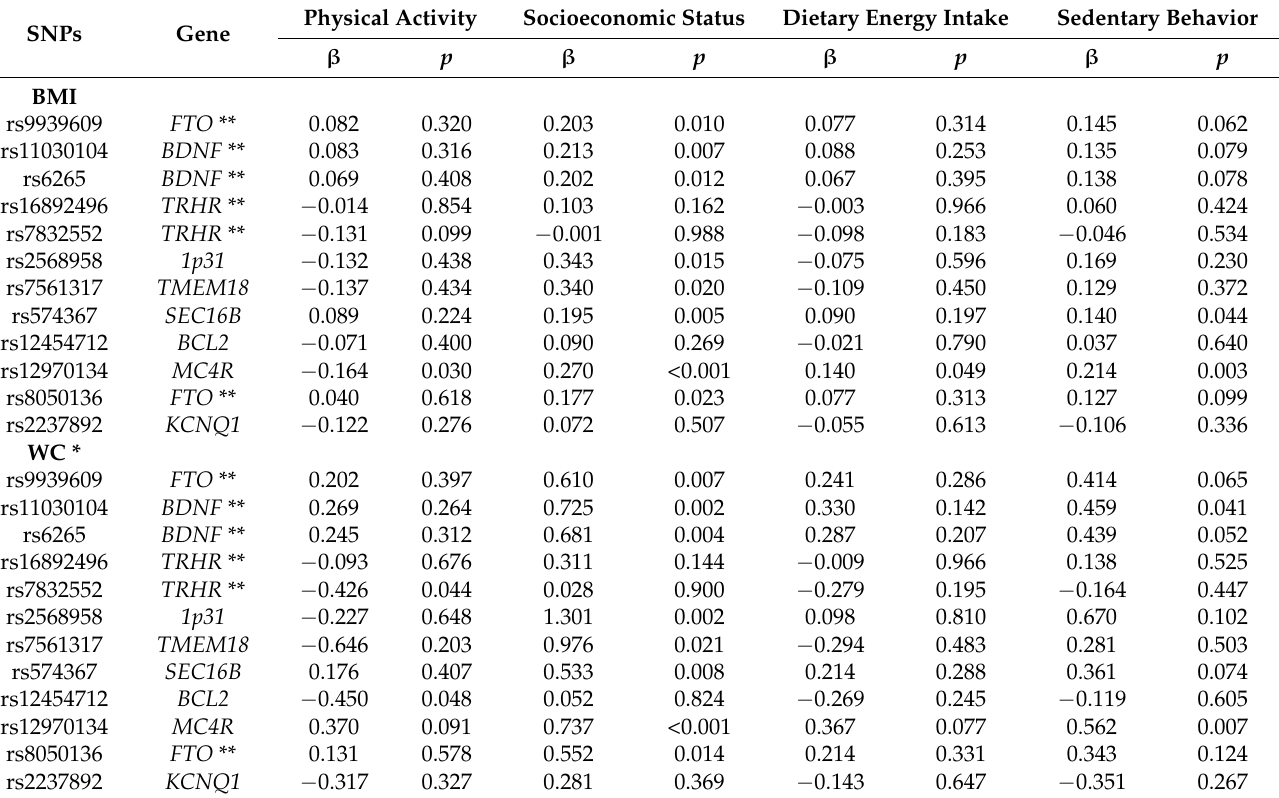
Table 3. Interaction of genes and environment on BMI and waist